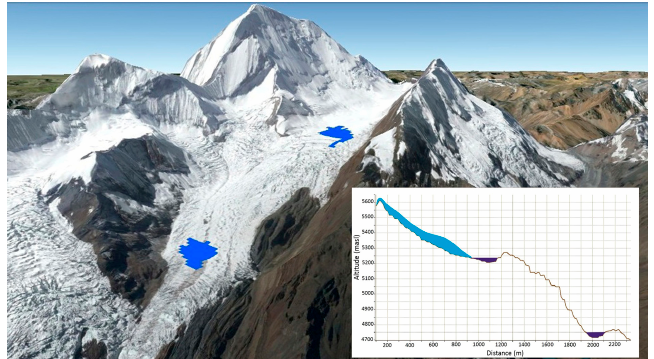
Figure 6. Glaciar Yerupajá 3, Cordillera Huayhuash, in 2007 with two possible future lakes; Google Earth image with longitudinal topographic profile through the two possible lakes (both approximately 400 m in length) in case of continued glacier retreat ( top ). Glaciar Shullcon 3, Cordillera Central, in 2009 with two possible future lakes; Google Earth image and longitudinal topographic profile through the two possible lakes (both approximately 500 m in length) in case of continued glacier retreat ( bottom ).